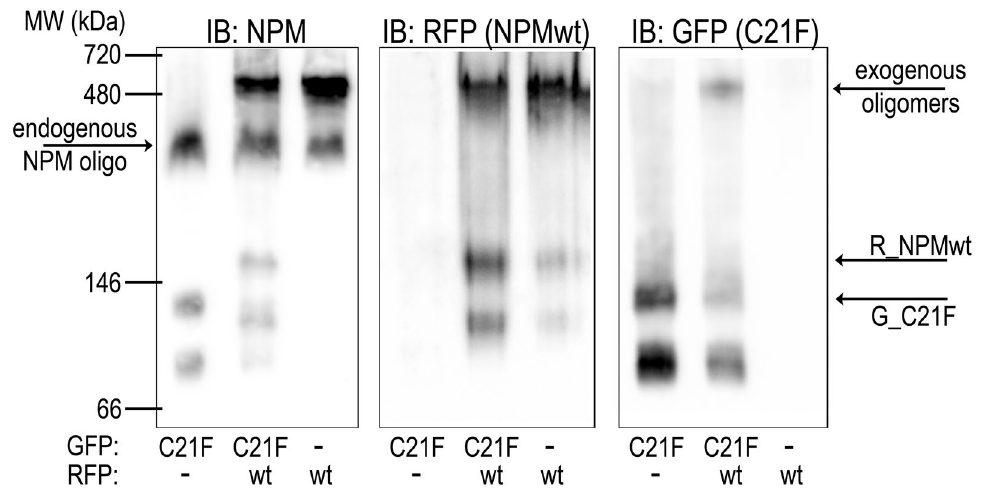
Figure 3. Formation of heterooligomers containing NPM with C21F substitution and NPMwt. Western blots of native PAGE of samples from 293T cells transfected with R_NPMwt (wt), G_C21F (C21F), and with their combination. Similar results were obtained with the inverse tagging, i.e. with G_NPMwt and